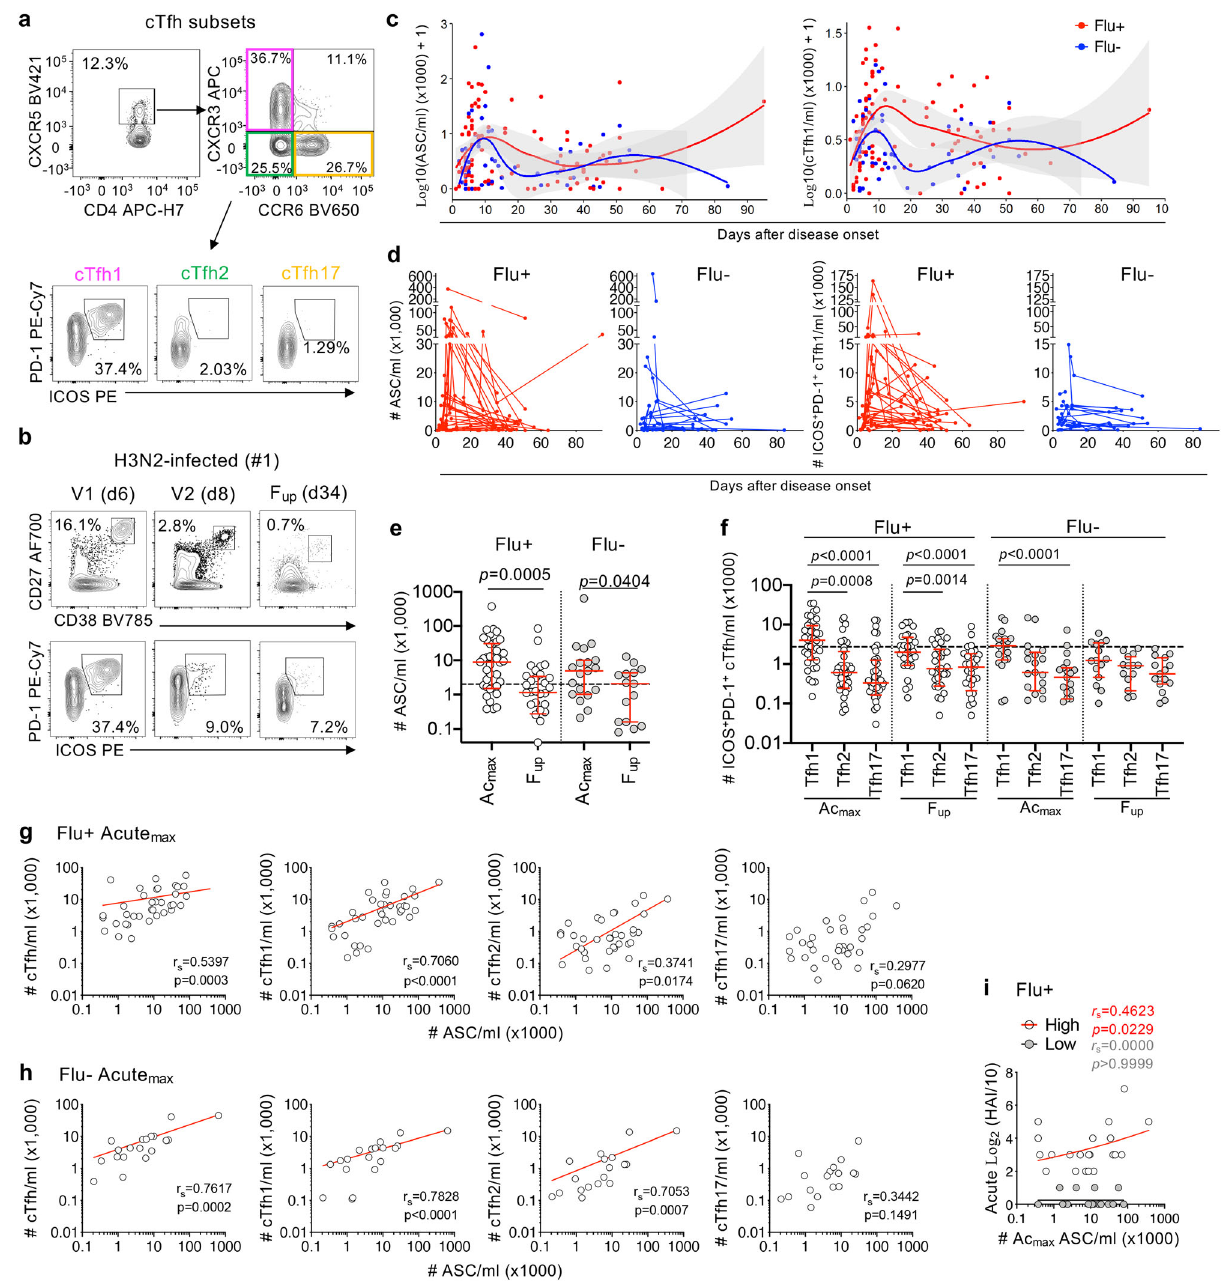
Fig. 3 Circulating Tfh cells, ASCs and in fl uenza-speci fi c B cell responses. a Representative FACS plots of CD4 + CXCR5 + cTfh subsets (cTfh1/2/17) and expression of activation markers PD-1 and ICOS. b Representative FACS plots of CD19 + CD20 -/lo CD27 ++ CD38 ++ ASCs and PD-1 + ICOS + activated CXCR3 + CCR6 – cTfh1 cells at acute (V1 and V2) and follow-up (F up ) timepoints. Days (d) after disease onset are shown in brackets. c , d Numbers of ASC and cTfh1 cells of in fl uenza + (Flu + , red, n = 44) and in fl uenza- (Flu-, blue, n = 20) patients after disease onset. Gray shading in ( c ) represents 95% con fi dence intervals. e Numbers of the peak ASC responses during acute ILI (Ac max ) versus F up in in fl uenza + (open circles, Ac max n = 40, F up n = 32) and in fl uenza- patients (gray circles, Ac max n = 19, F up n = 15). f Peak cTfh responses of different Tfh1/2/17 subsets at Ac max (in fl uenza + n = 40, in fl uenza- n = 19) and F fl uenza + n = 32, in fl uenza- n = 15) timepoints. g , h Correlation (two-tailed Spearman correlation coef fi cient, r up (in s ) between Ac max ASC and cTfh responses and ( i ) Ac max ASC responses with HAI antibody titres of high (HAI ≥ 40) and low responders (HAI < 40) during acute infection. e , f Red bars indicate the median and IQR for cell numbers. Dashed line is the median baseline level for healthy controls. Statistical signi fi cance (0.0001 > p < 0.05) was determined using the two-tailed ( e ) Mann – Whitney test and ( f ) Friedman test. g – i Statistically signi fi cant p values are shown (0.0001 > p <